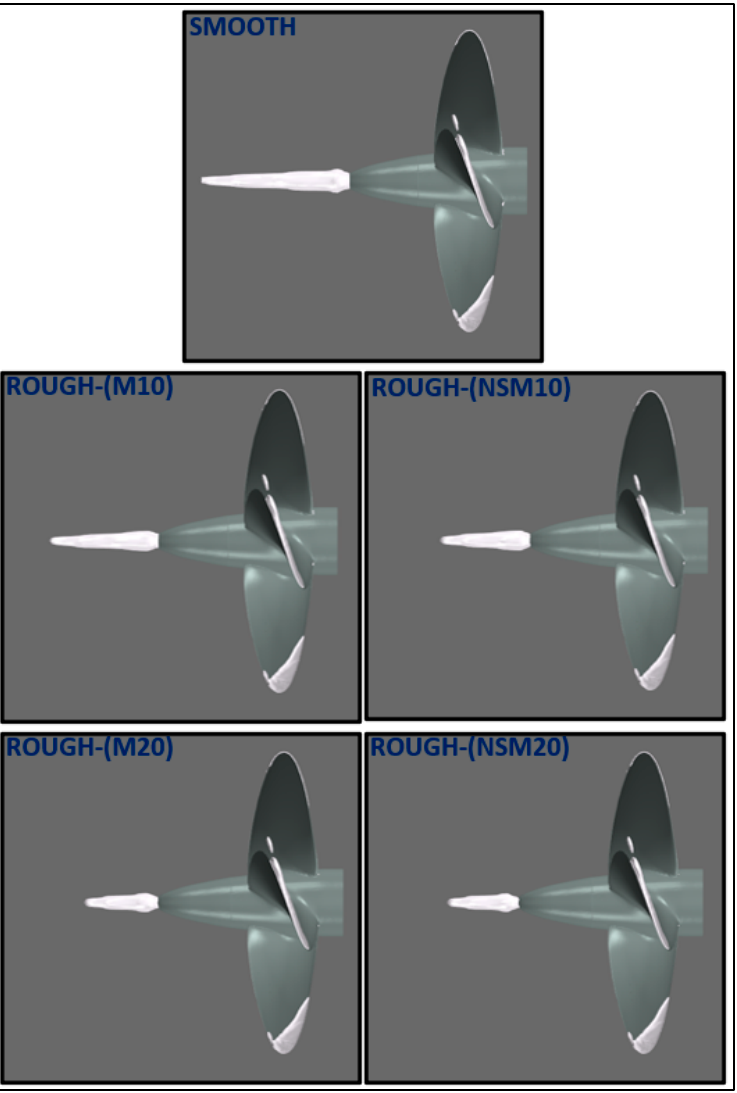
Figure 12. Mitigation of hub vortex cavitation with roughness ( 𝛼 (cid:3049) = 0.1) .